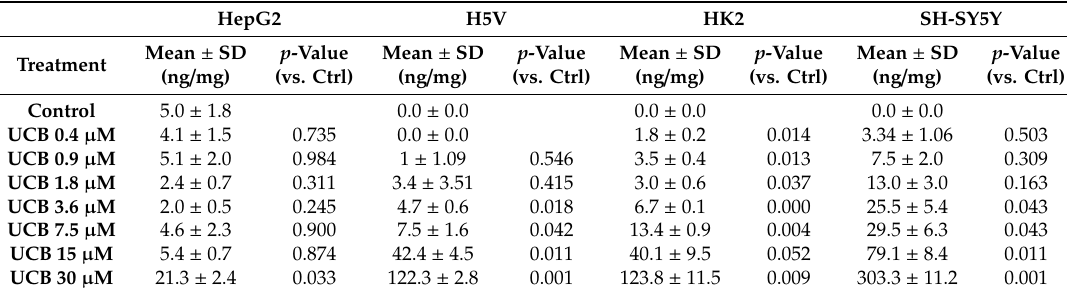
Table 1. The e ff ect of UCB exposure to intracellular UCB concentrations. The cell lines were exposed for 24 h to the increasing UCB concentrations (from 0.4 to 30 µ M in the presence of 30 µ M BSA) or 0.5% DMSO. Data are expressed as mean ± SD of three independent experiments, UCB concentrations were recalculated per mg of protein. p -values represent comparison with control